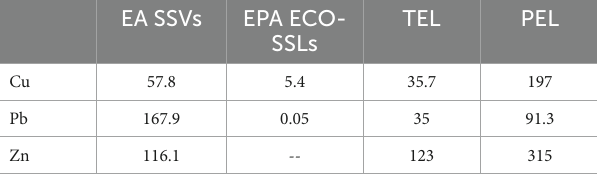
TABLE 1 Guidance values for good soil and sediment quality, including the UK Environment Agency’s non-statutory Soil Screening Values (SSVs: Environment Agency, 2017), the United States Ecological Soil Screening Levels (ECO-SSLs), and Threshold Effects Levels (TEL) and Probable Effects Levels (PEL – 50% adverse effects occur above this) taken from NOAA Buchman Screening Quick Reference Tables (2008).